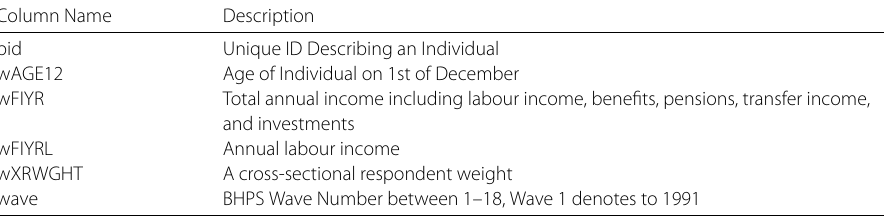
Table 1 Description of Variables from the British Household Panel Survey spanning years